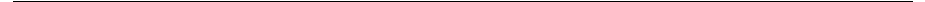
Table 6. Ordinal regression of digital competence profile with 500 bootstraps ( n 460). =